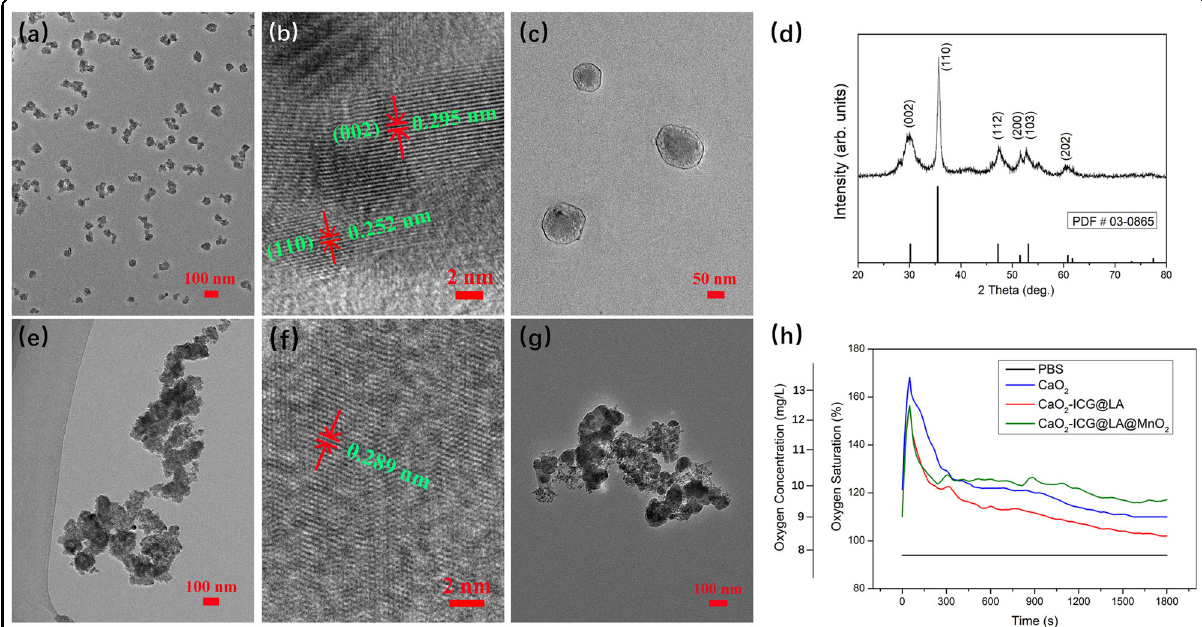
Fig. 1 Morphologies, structures, and the oxygen-producing capacities of the oxygen-releasing nanoparticles. a TEM and ( b ) HR-TEM images of